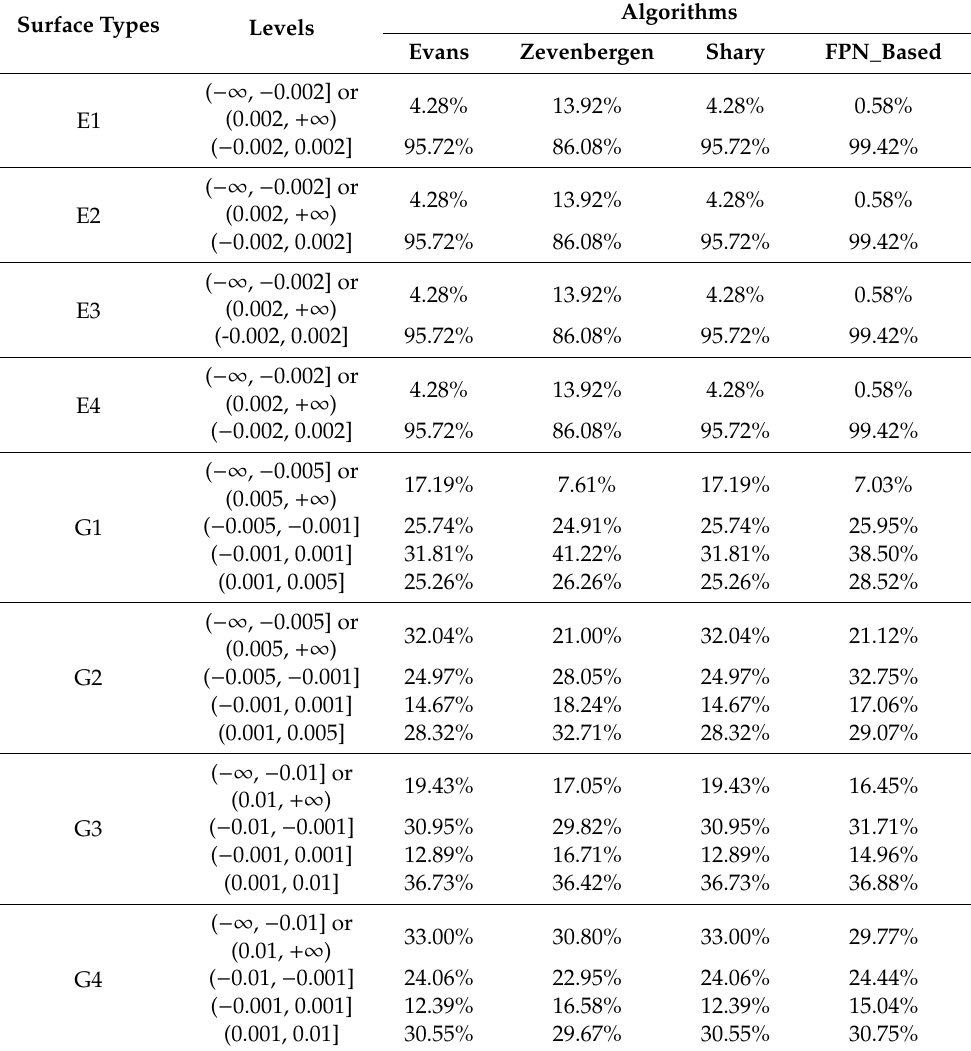
Table 7. Proportion of residual values within di ff erent levels of the four methods on E1, E2, E3, E4, G1, G2, G3, and